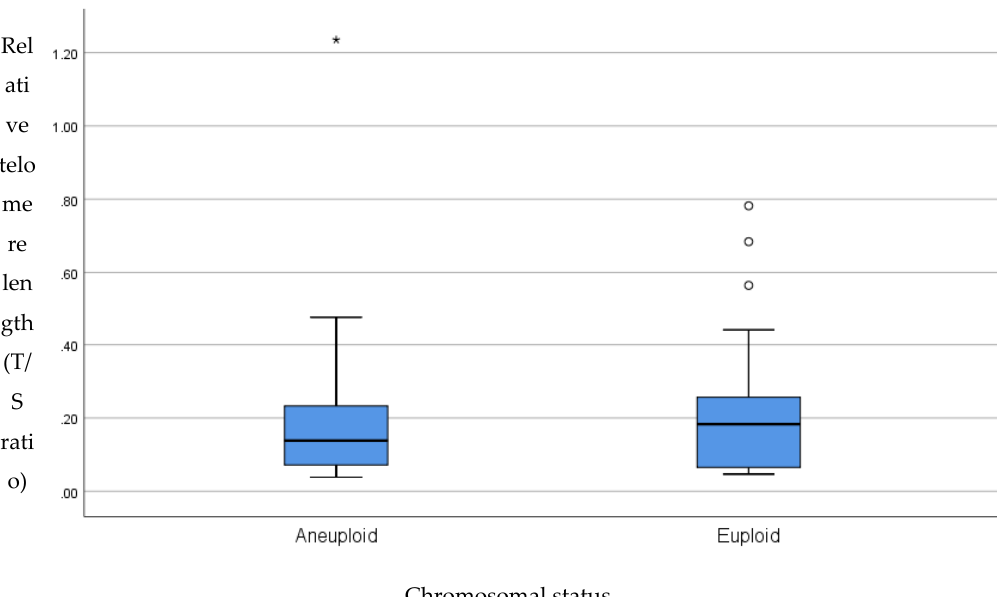
Figure 8. Relative telomere length of euploid ( n = 21) and aneuploid ( n = 21) blastomeres assessed from all couples. Results show no significant difference ( p = 1.0). The line on the lower end of the whisker represents the minimum T/S ratio, the bottom of the box represents the first quartile, the line through the middle region of the box represents the median T/S ratio, the top of the box represents the third quartile and the line at the top of the whisker represents the maximum T/S ratio. Circles represent outliers between 1.5 and 3 box lengths from the upper region of the box. Asterisks represent extreme outliers that are more than three times the interquartile range from the third quartile.